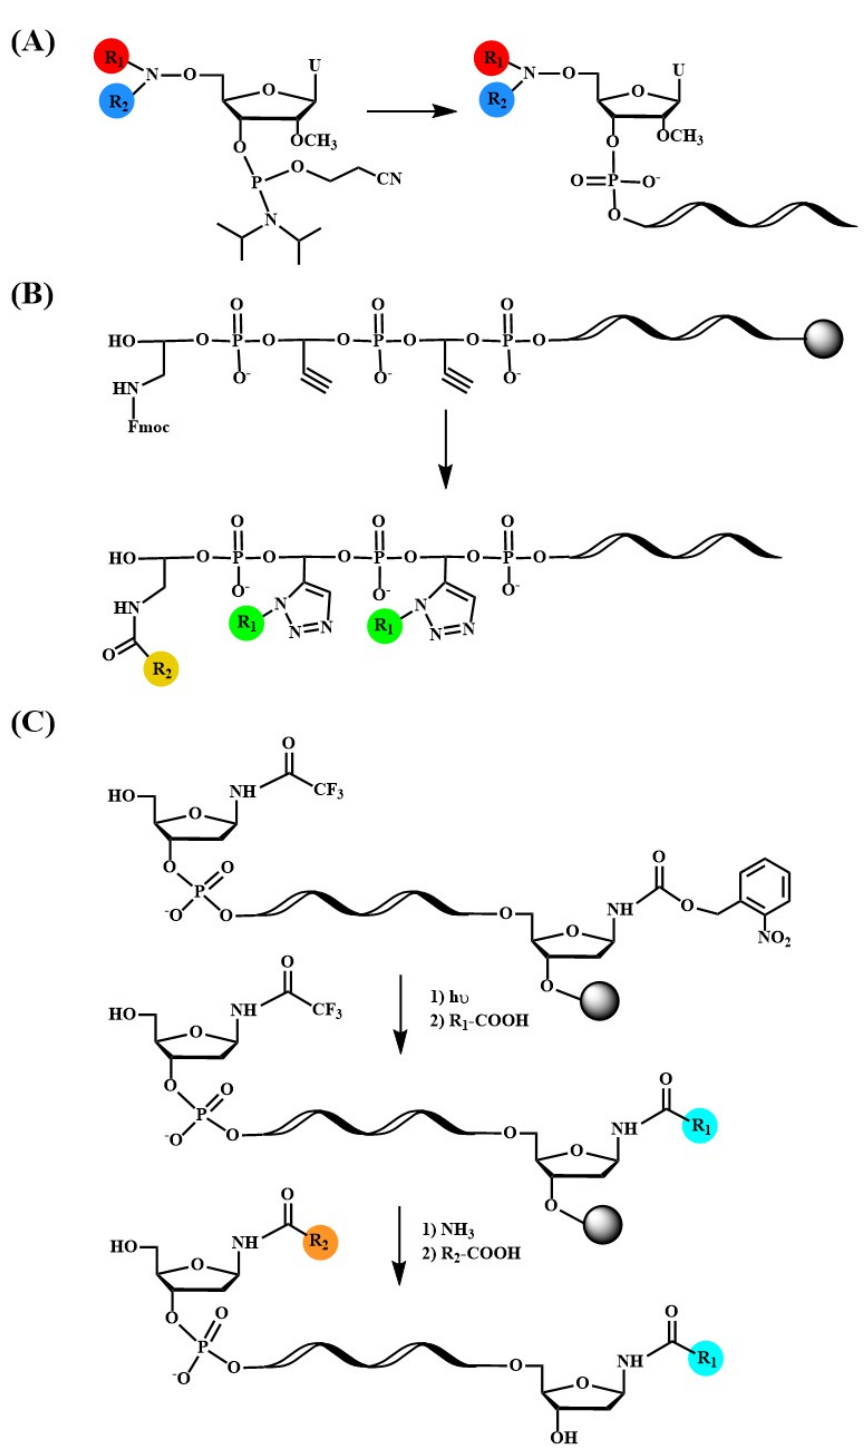
by hybridization of several monofunctionalized oligonucleotides in simple or complex DNA nanoassemblies (Figure 8).